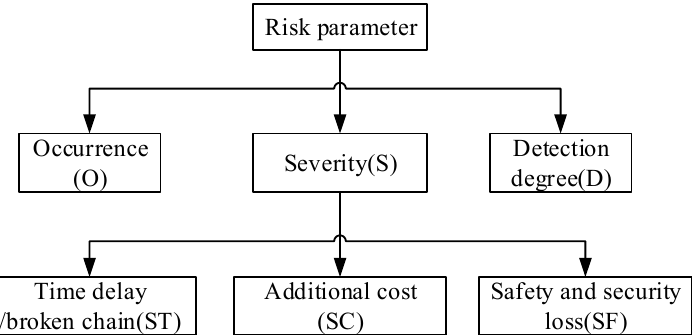
Figure 2. Risk parameter characterization system.